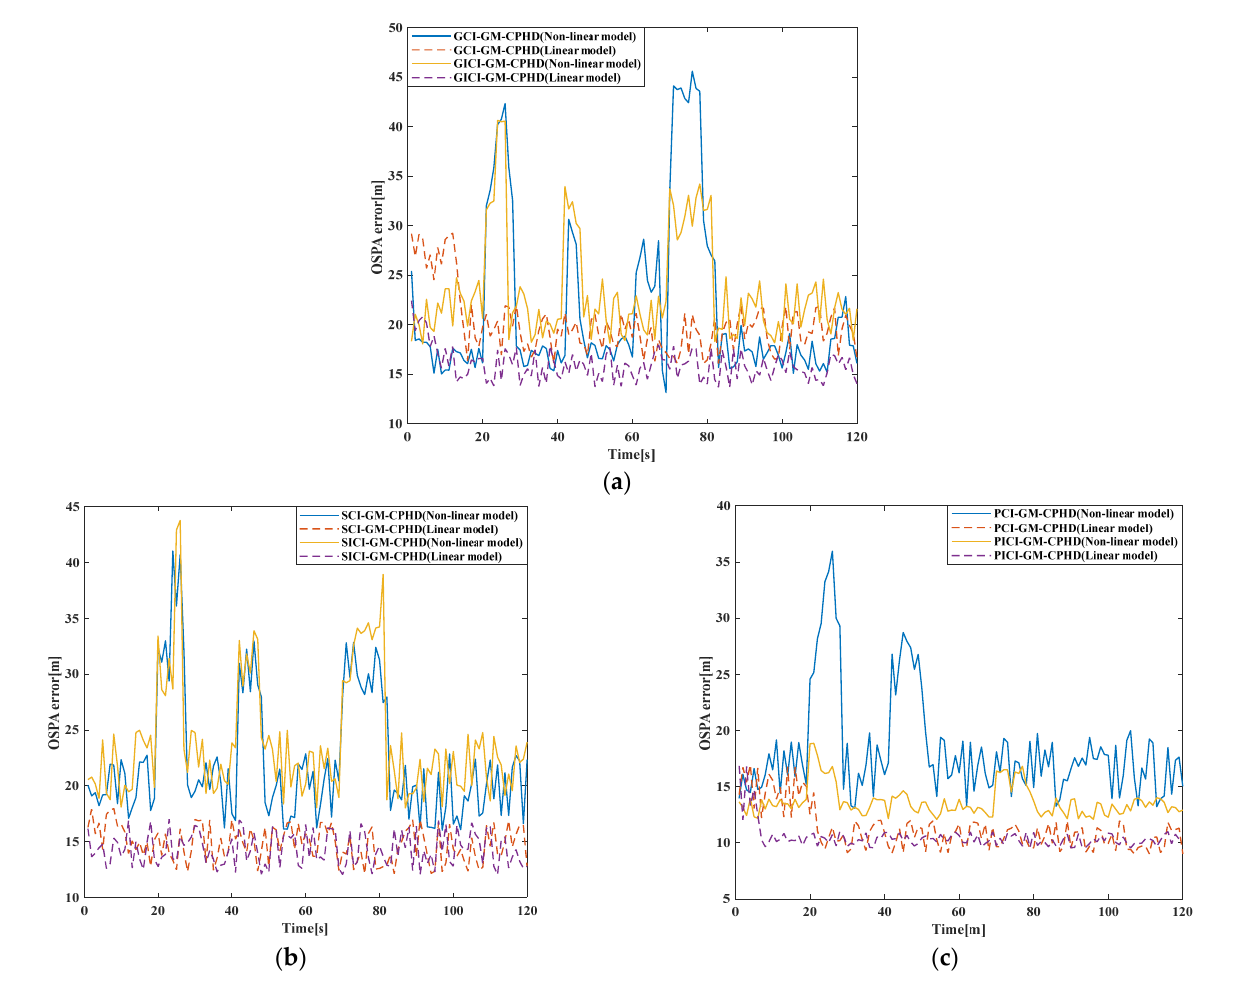
Figure 12. Comparison of OSPA distance errors of several algorithms in nonlinear models. ( a ) GCI, GICI; ( b ) SCI, SICI; ( c ) PCI, PICI. Table 4. Comparison results of algorithm running